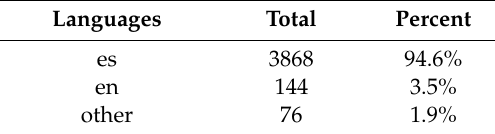
Table A51. Primary languages (es).